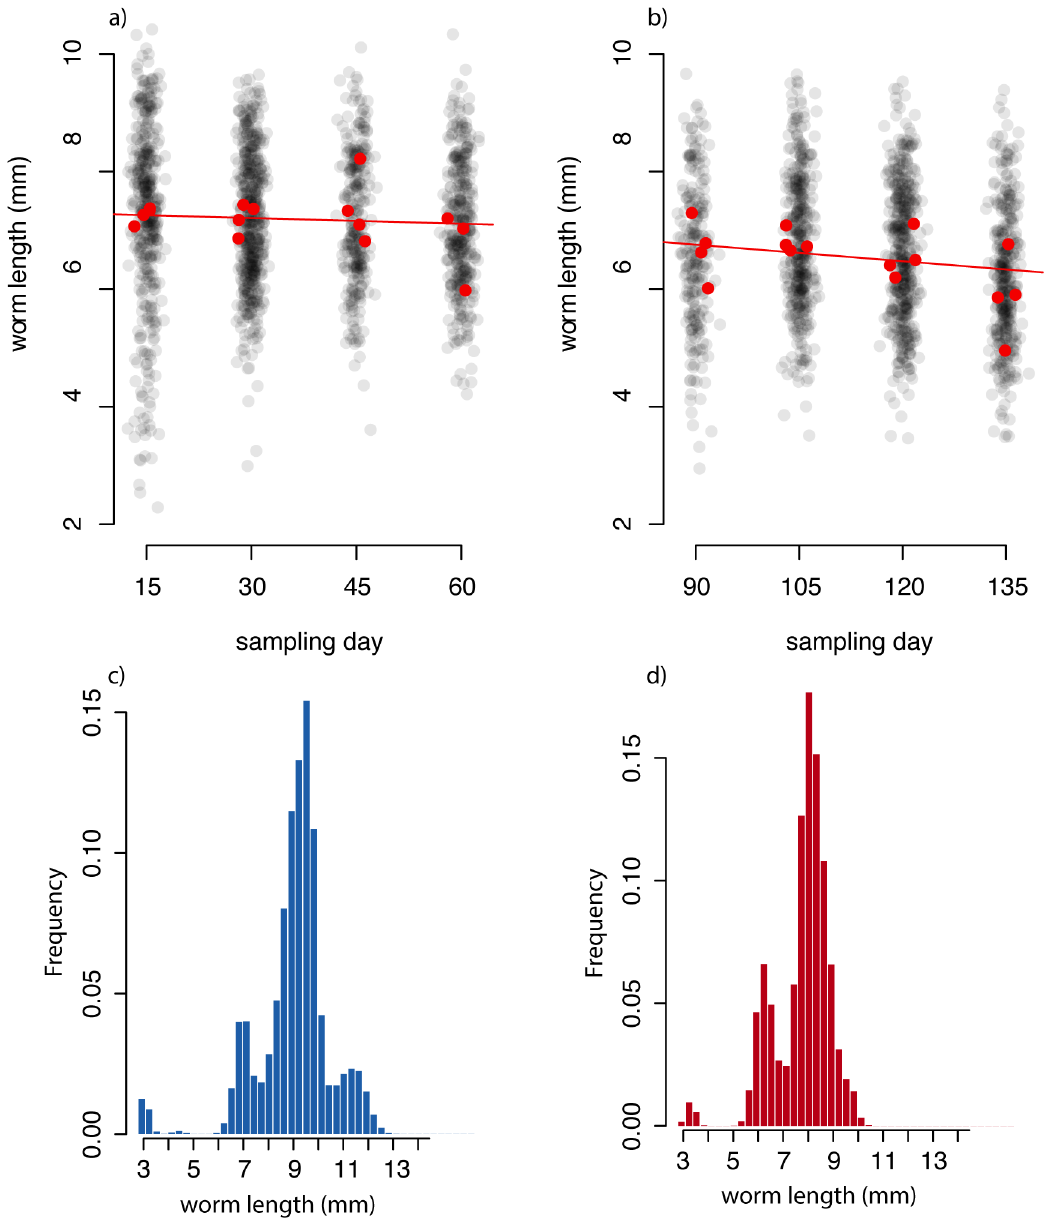
Fig 2. Distribution of observed and simulated worm lengths. (a) The distribution of parasite lengths over time for the pre- treatment phase of the experiment. Black circles give the lengths of all observed worms on each sampling day. Red circles give the mean parasite length for each rabbit. Circles have been jittered in the x-dimension for clarity. The red line indicate the linear trend in the mean parasite length. (b) The distribution of parasite lengths over time for the post-treatment phase of the experiment. Circles and line are as in panel (a)). (c) and (d) The simulated distribution of parasite lengths at day 60 for pre- and post-treatment phases,